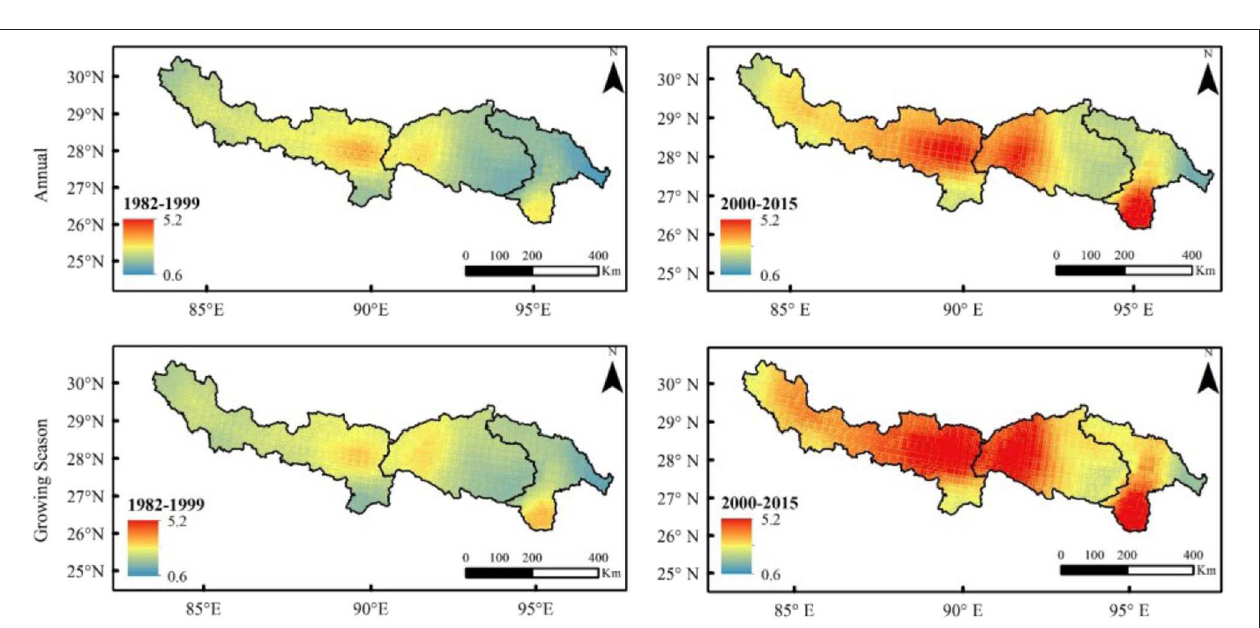
FIGURE 8 | Annual and growing season spatial distributions of